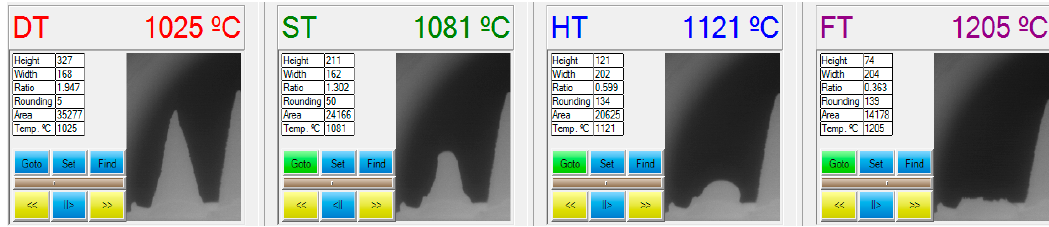
Figure 5. Measurement of ash sample S100.